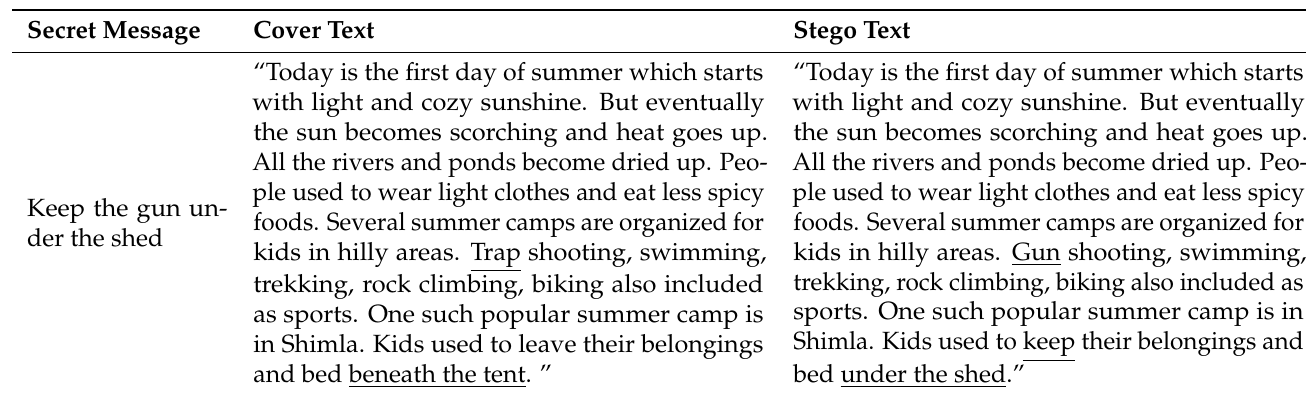
Table 3. Example of Linguistic Steganography (Data from [31]).